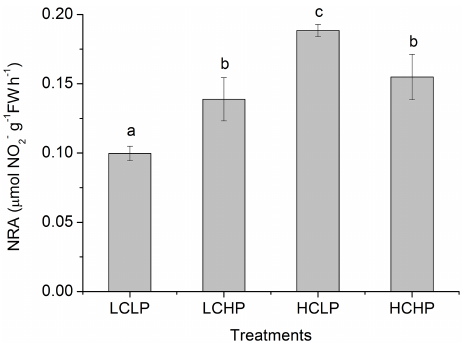
Figure 6. Nitrate reductase activity (NRA) of S. muticum after be- ing grown at different p CO 2 and P conditions for 13 days. Data are reported as means means ± SD ( n = 3). LCLP is the low p CO 2 and low P condition, LCHP is the low p CO 2 and high P condition, HCLP is the high p CO 2 and low P condition, and HCHP is the high p CO 2 and high P condition. Different letters above the error bars indicate significant differences between treatments ( P < 0 .